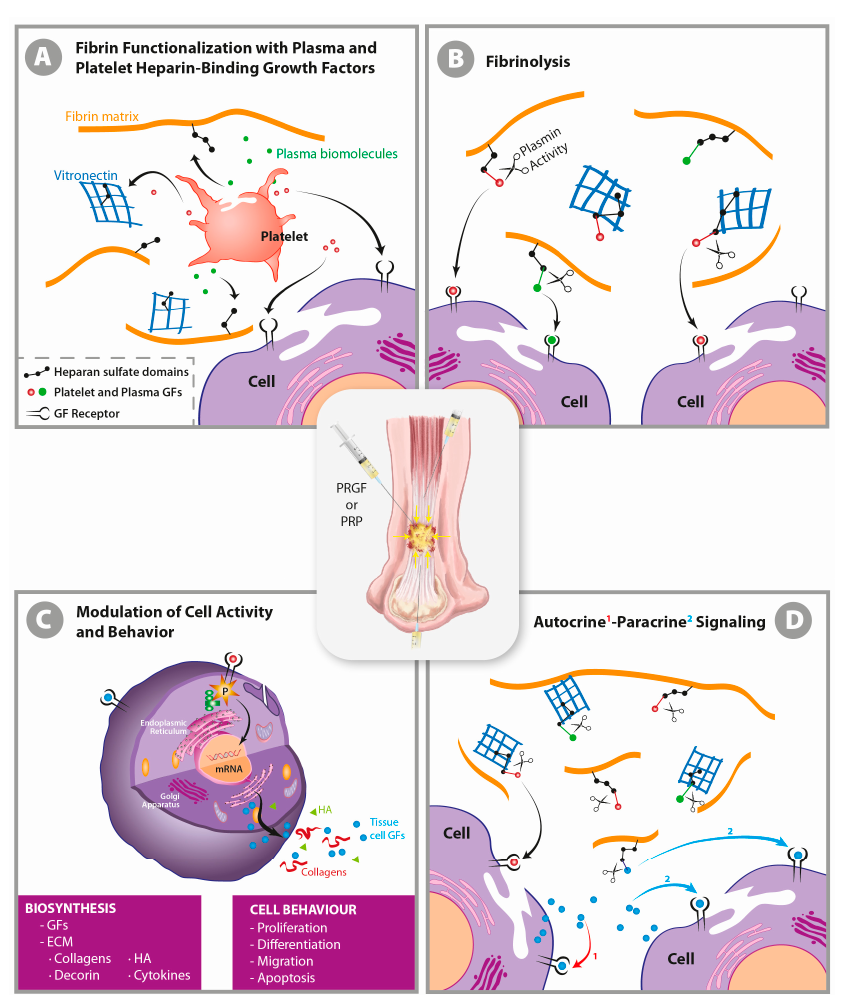
Figure 1. An autologous liquid-to-gel dynamic scaffold as a carrier of biological mediators in